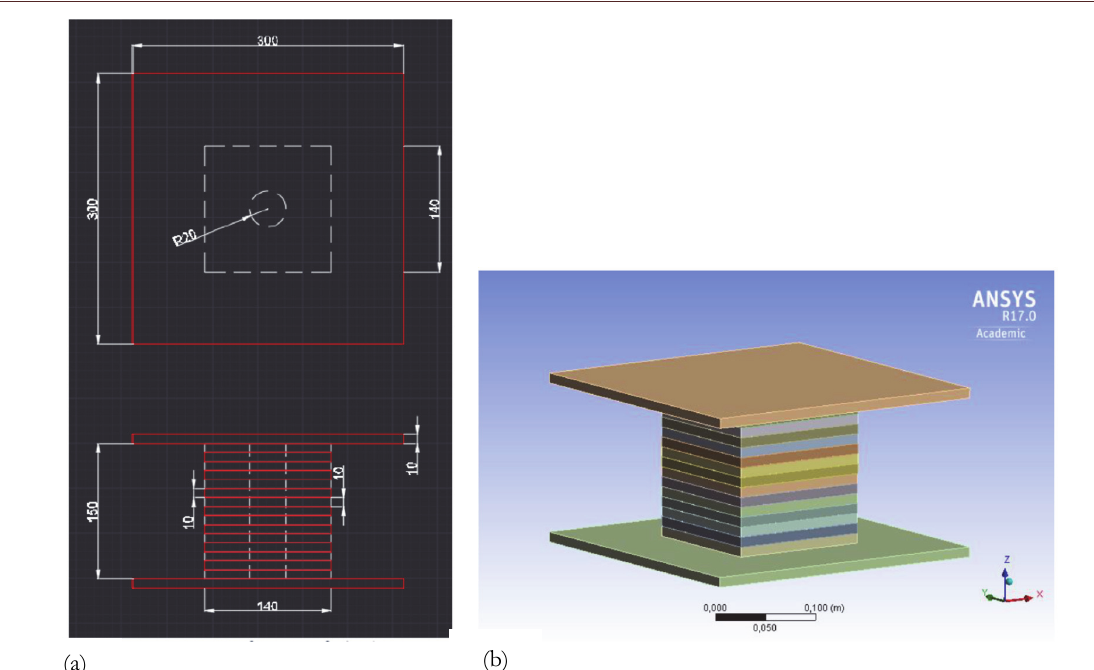
Figure 2: (a) Geometry of typical Lead-Rubber Bearing base isolator (mm), (b) Three-dimensional isometric view of the Lead-Rubber Bearing base isolator model.